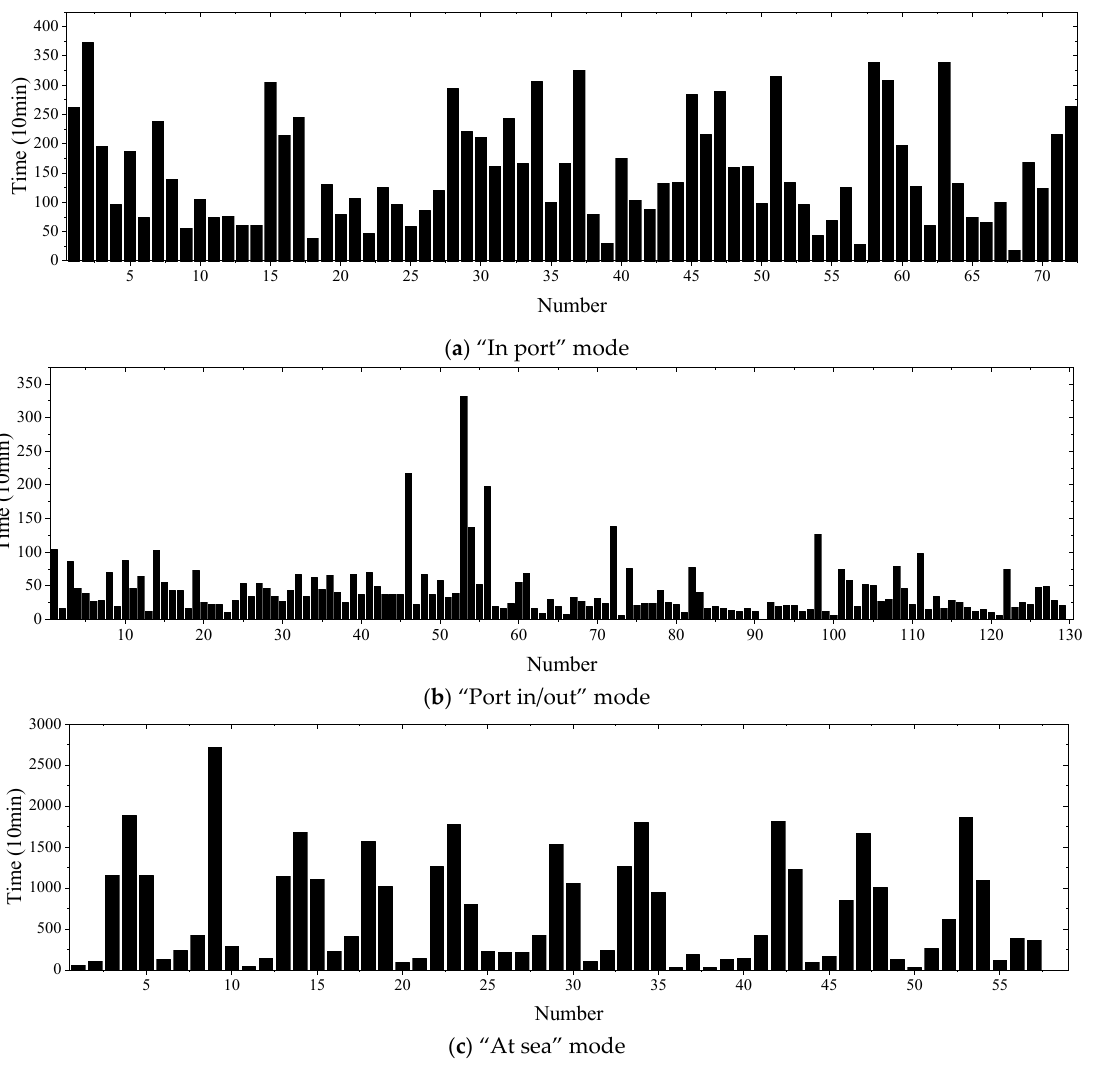
Figure 2. Operation time in each mode. Figure 3 shows the change in the load and operation mode of the ship according to the time the data were acquired, “0, 1, and 2 modes of the ship” indicate “In port”, “At sea”, and “Port in/out” modes, respectively.